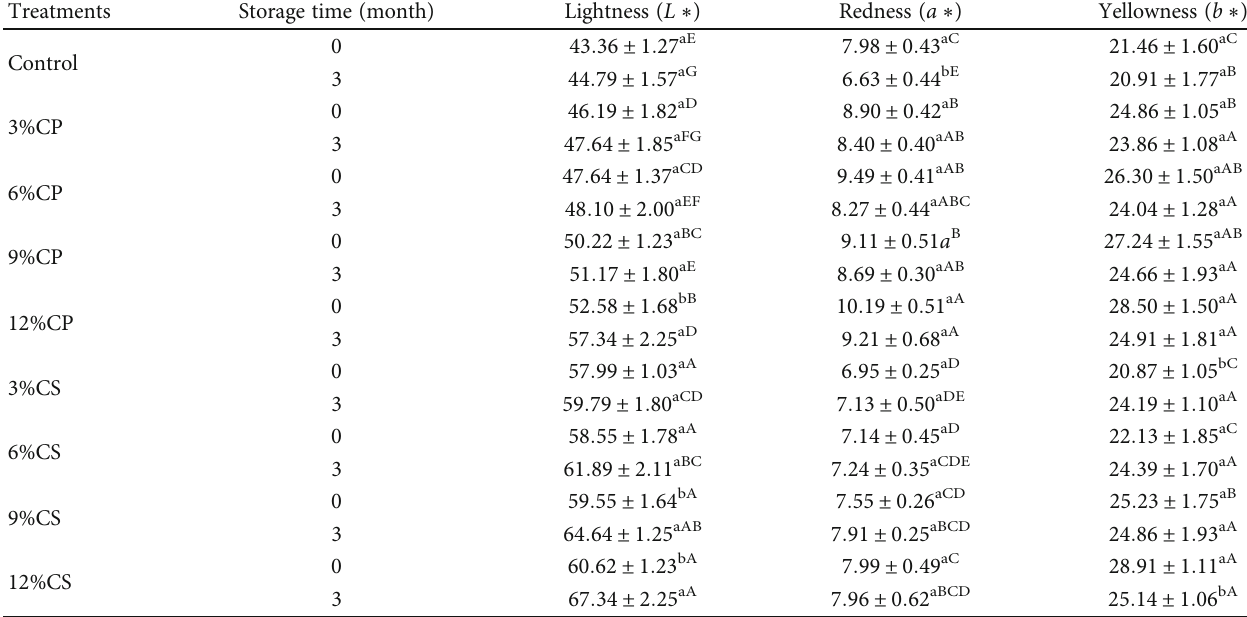
Table 8: Changes in color values of cooked chicken patties supplemented with cantaloupe peel (CP) and seeds (CS) powder during storage at -20 for 3